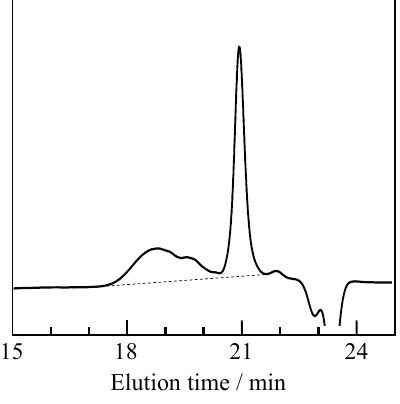
Figure 2. SEC profile of oligo(P-4va).